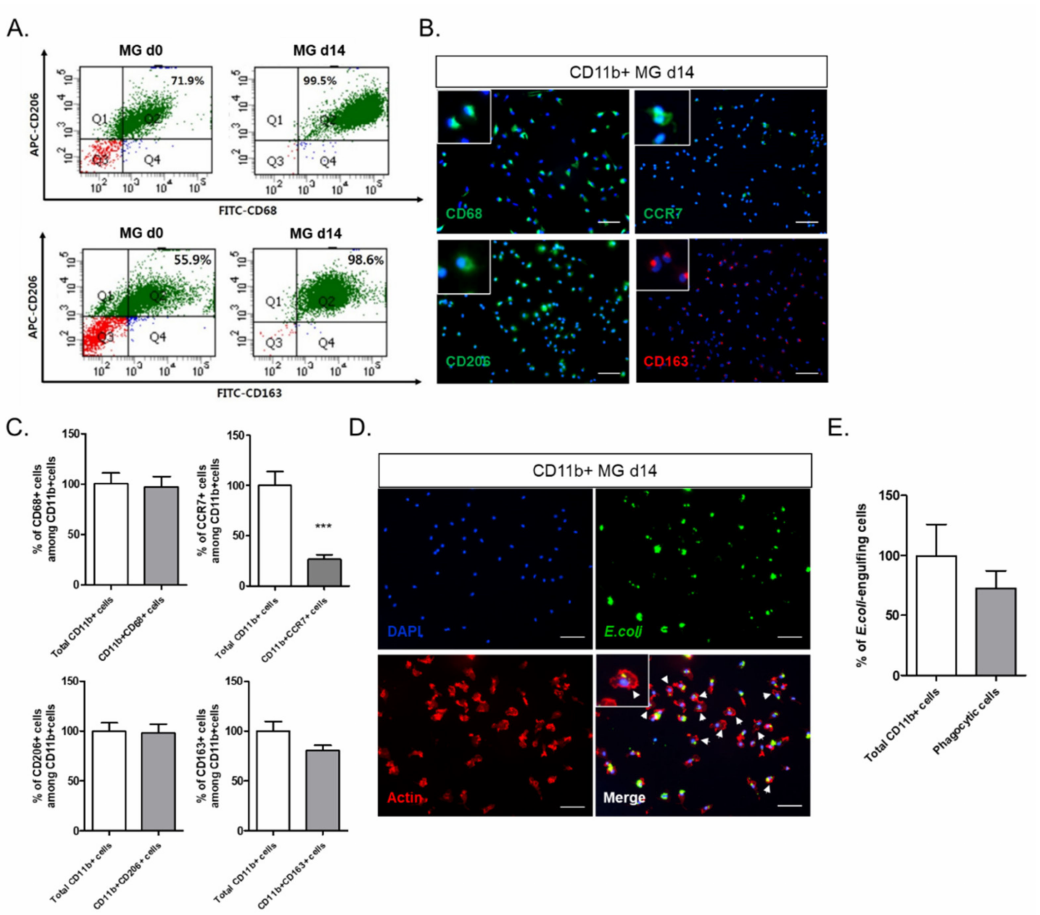
Figure 2. Phenotypic identity of MG d14 as M2 microglia: ( A ) flow cytometry analysis of MG d0 and MG d14 with CD206, CD68, and CD163 antibodies. CD206 + CD68 + cells and CD206 + CD163 + cells increased in MG d14; ( B ) fluorescence images of CD68, CCR7, CD206, and CD163 in MG d14. Left white box: magnified image of each marker positive cell. ( C ) quantitative analysis of CD68 + , CCR7 + , CD206 + , and CD163 + cells among CD11b + cells. ( n = 5); ( D ) fluorescence image of the phagocytosis assay of MG d14. Left white box: magnified image of E. coli -particle-positive cells. White arrowhead: actin ruffles; ( E ) quantitative analysis of E. coli -particle-engulfing cells among MG d14 ( n = 5). *** p < 0.001; scale bar = 100 µ